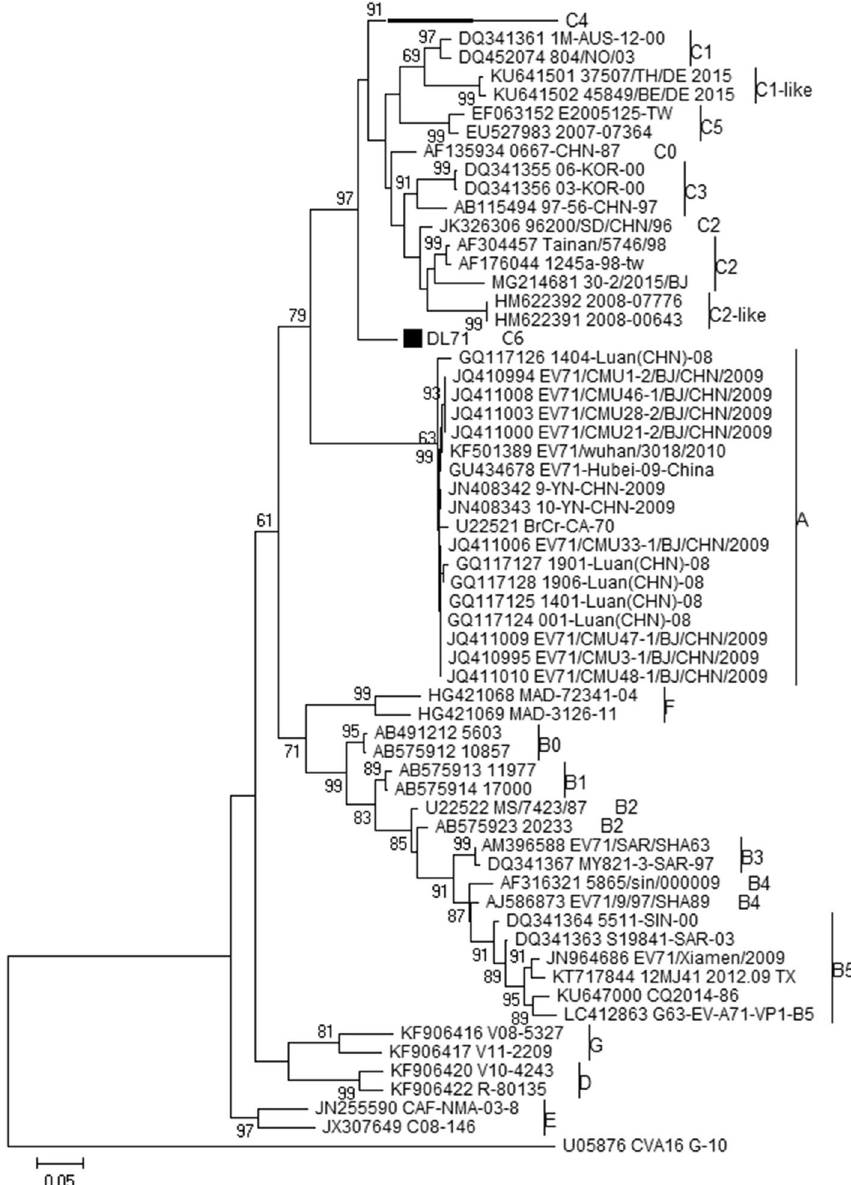
Figure 1. Phylogenetic tree based on the VP1 sequences of EV-A71. The evolutionary tree was constructed using the maximum likelihood method with the General Time Reversible (GTR) model by MEGAX. Bootstrap values were calculated by 1000 replicates. Bootstrap values lower than 60% are hidden. The branch of subgenotype C4 is compressed to save space. The solid square (black filled square) indicates the